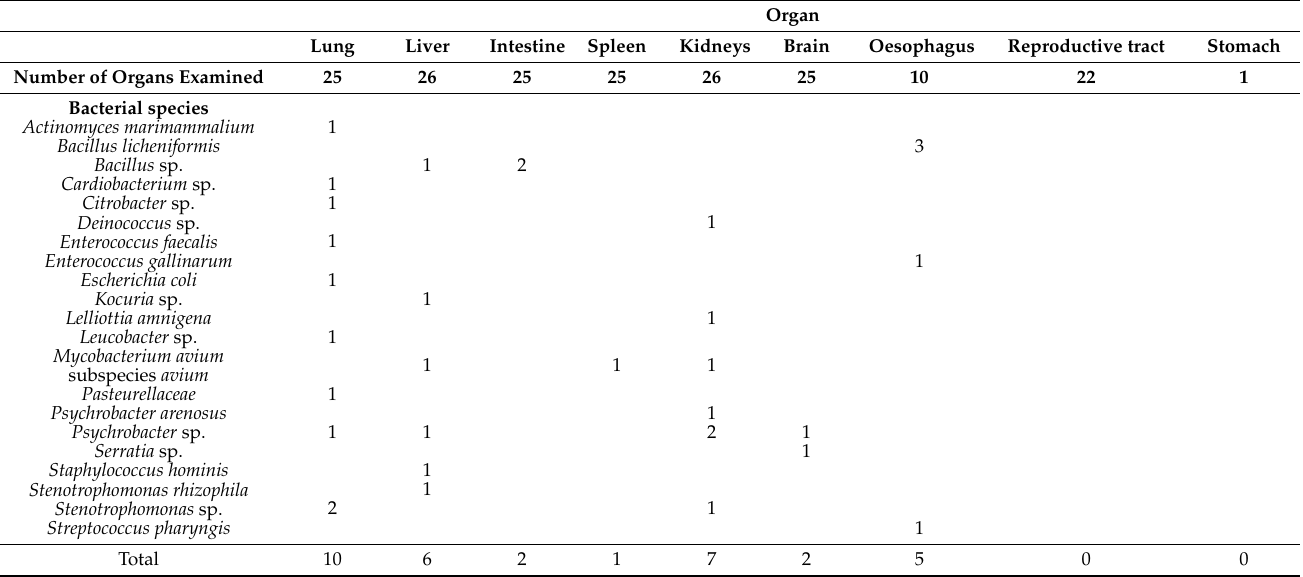
Table 6. Bacterial species detected in the organs of 29 animals, listed by organ systems.